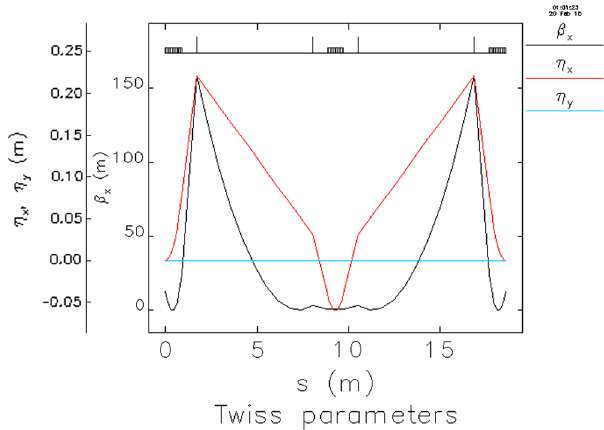
FIG. 2. Beam line layout and Twiss functions for the optimum value m 21 ¼ 15 = 2 L B . ELEGANT